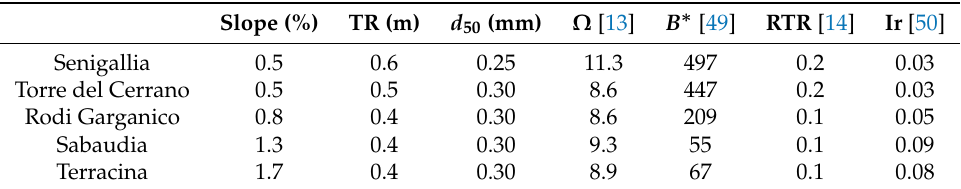
Table 4. Environmental and classification parameters used to characterize the main morphological behaviour of the study sites.